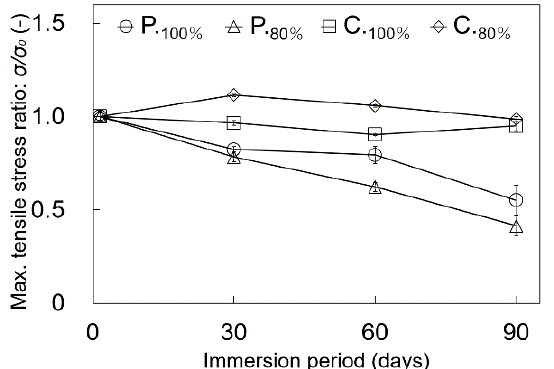
Figure 10. Comparison of the changes in the maximum tensile stresses of the four test piece types brought about by the immersion. Each value was divided by the average value of the non-im- mersed test pieces (0 days). The plot points were straggled to avoid overlapping. Average ± S.D., N = 5.